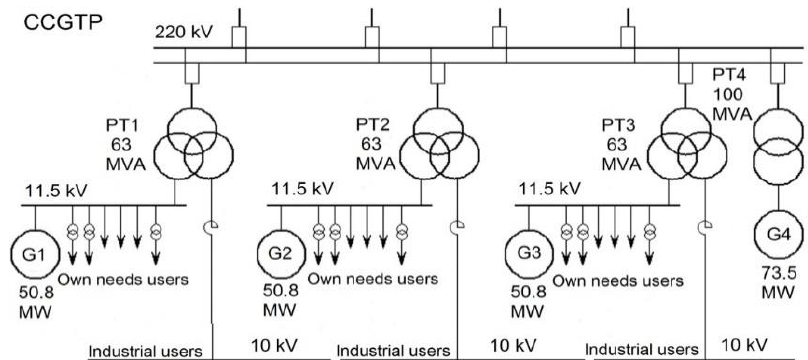
Figure 2. A simplified single-line schematic circuit diagram of the CCGTP.